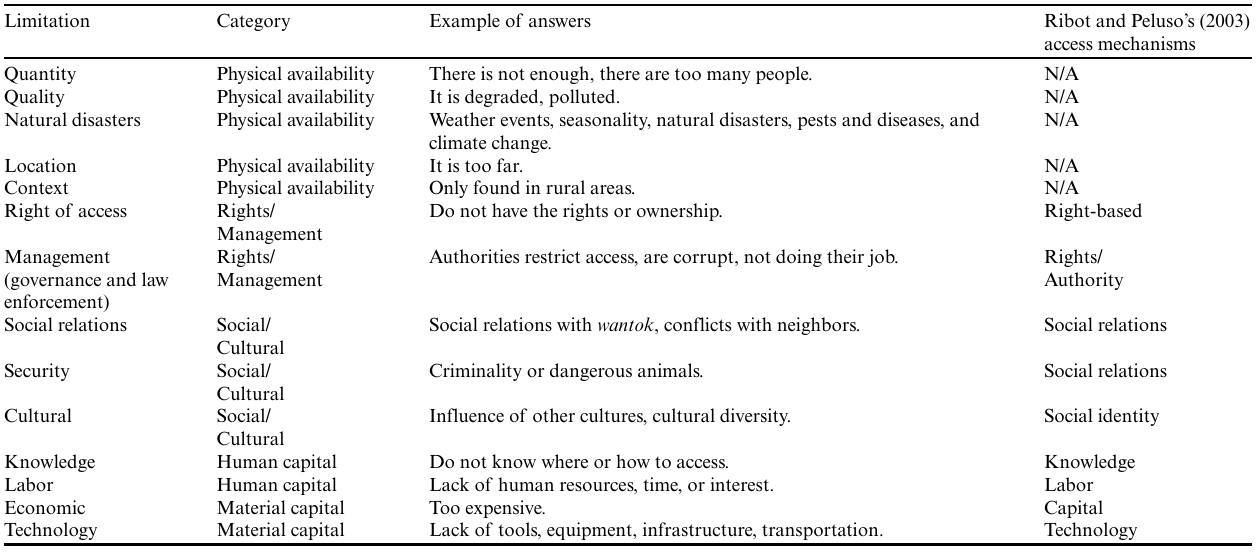
Table 1 . Availability and access limitations classification and correspondence with Ribot and Peluso’s theory of access